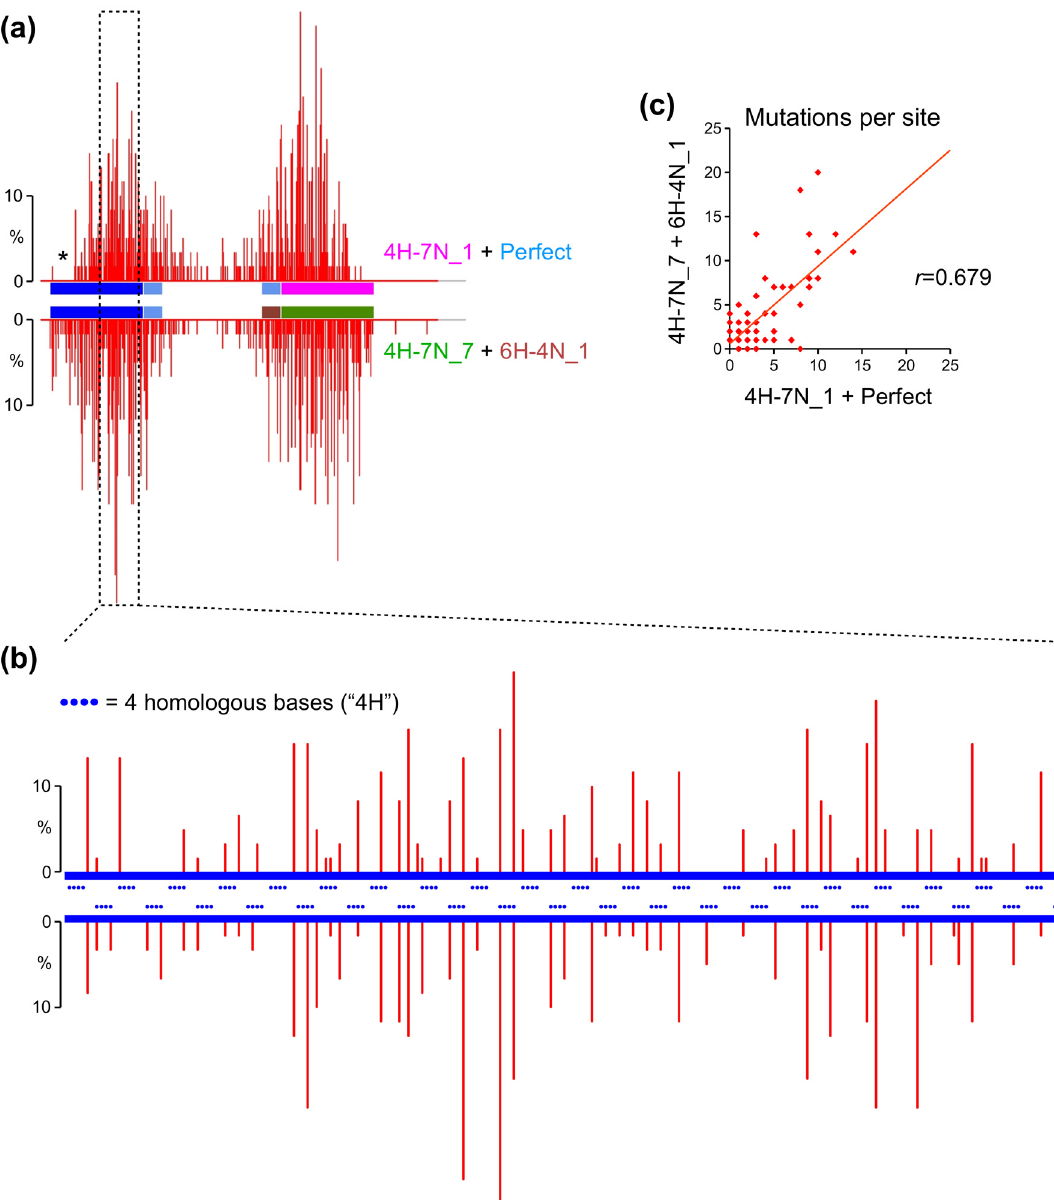
Fig 7. Homology recognition and ensuing mutation are not coupled with respect to the involved base-pairs. (a) RIP mutation profiles of the two diagrammed repeat constructs are compared along their entire lengths. A 200-bp portion of the reference sequence that appears to have similar levels of RIP in both cases is outlined. We note that a distal portion of the same reference sequence (marked with “ * ” ) escapes RIP in the case of 4H-7N_1 but not in the case of 4H-7N_7. (b) RIP mutation profiles along the 200-bp portion of the reference sequence at the base-pair resolution. “ ●●●● ” indicates the positions, in the reference sequence, of the 4-bp homologous units defined by the corresponding test sequences 4H-7N_1 (upper profile) and 4H-7N_7 (lower profile). (c) Correlation of mutations observed for individual sites within the 200-bp segment (Panel b). r is the Pearson correlation